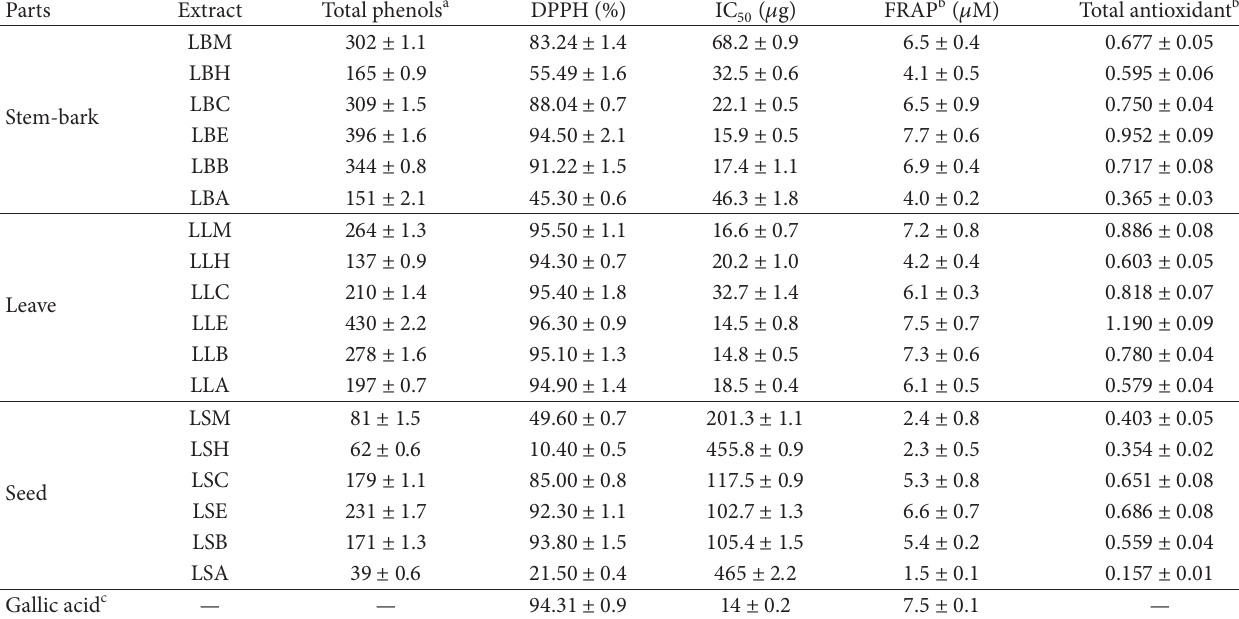
Table 1: Total phenolic contents and antioxidant activities of aerial parts of L. pulverulentus . Parts Extract